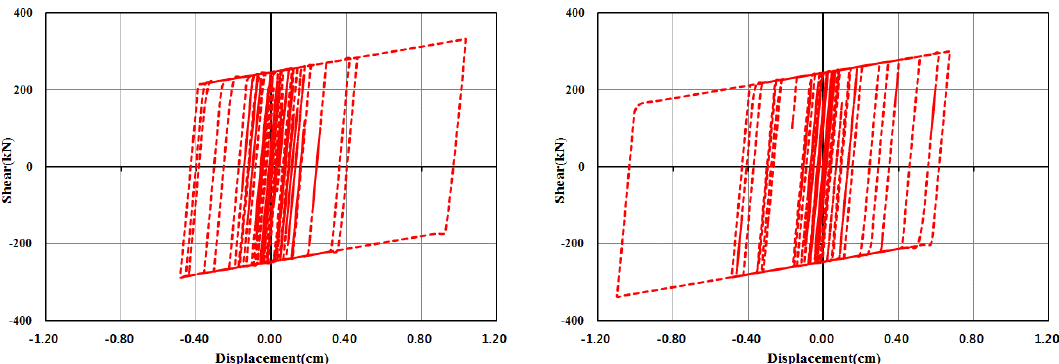
Figure 28. Hysteretic curves of the WKDS (El-Centro EW, 2F).